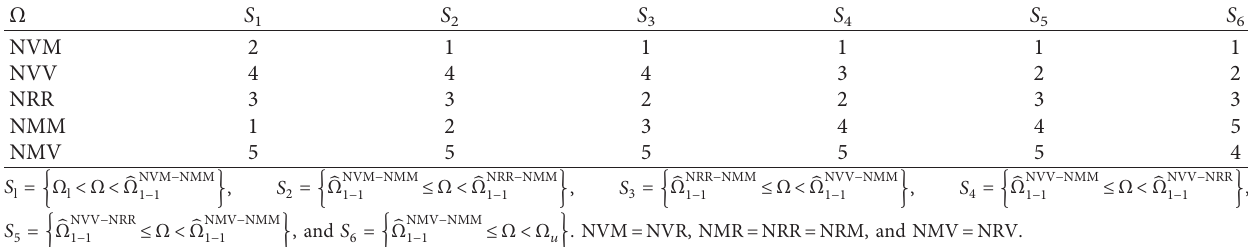
Table 5: Rank ordering with respect to channel 1 efficiency given Ω≠ 1 and θ ∈ ( 0 , 0 . 83 ]